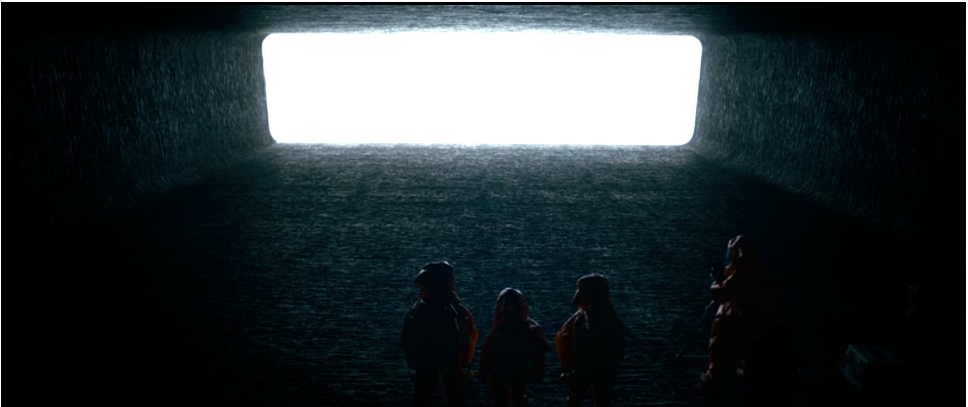
Figure 6: Arrival . Light at the end of the